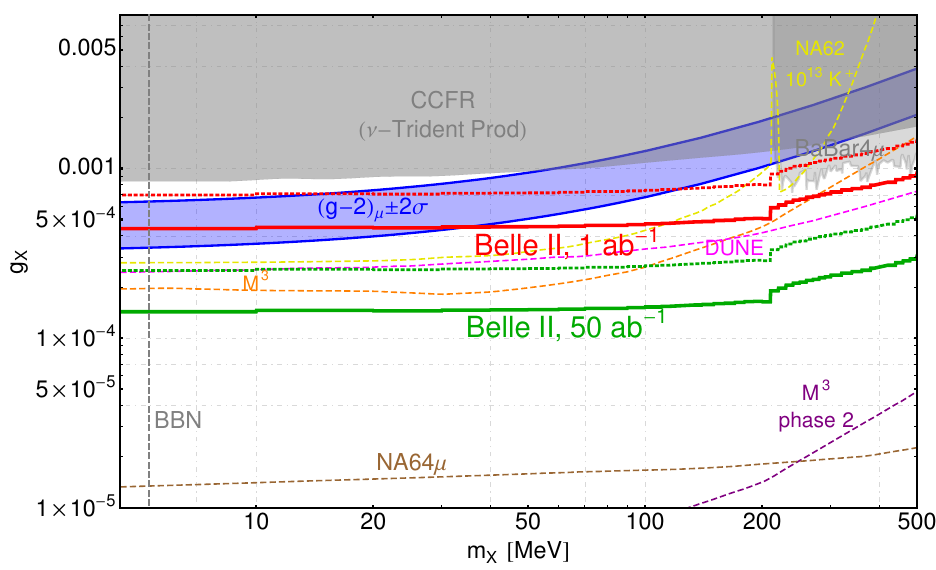
Figure 10 . Sensitivity limit corresponding to at R dt = 1 ; 50 ab (cid:0) 1 search in the Belle II experiment with the photon detection ine(cid:14)ciency L 1 (cid:15) (cid:13) = 10 (cid:0) 6 for (cid:22) (cid:0) (cid:22) + ( (cid:13) ) backgrounds (red, green solid lines). We show the case with 1 (cid:0) (red, green dotted lines) as the conservative choice of detection ine(cid:14)ciency. Expected sensitivities of future coming beam-dump experiments such as M 3 [23] (orange, purple dashed lines), NA64 (cid:22) [61] (brown dashed line), NA62 with 10 13 kaons [37] (yellow dashed line) and neutrino trident production in DUNE [62] (magenta dashed line) are also shown for comparison.